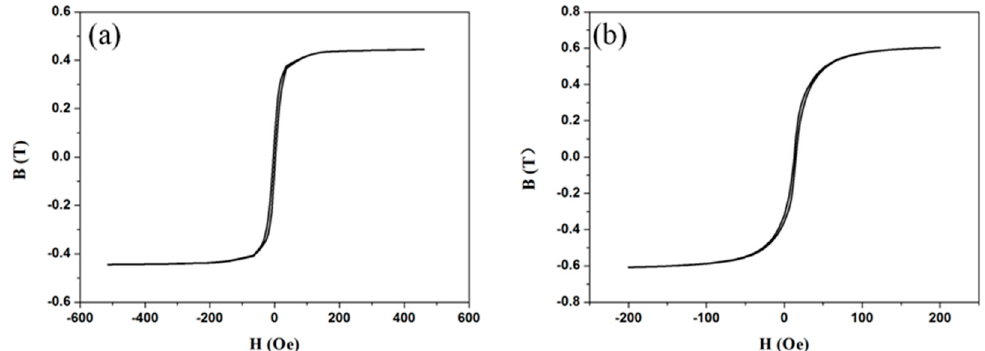
Figure 13. Hysteresis loops of ( a ) as ‐ cast and ( b ) glass ‐ removed Fe 73.5 Cu 1 Nb 3 Si 13.5 B 9 fibers.